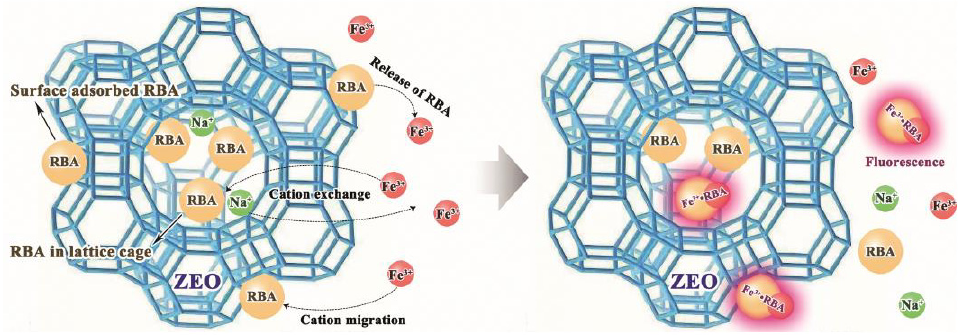
Figure 12. The mechanism of the loading, release and fluorescence activity of RBA.